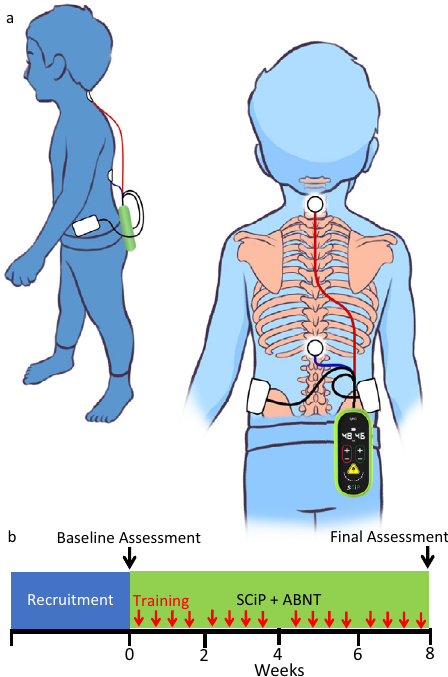
Fig. 1 | Overall Experimental Design. a Experimental setup demonstrating the placement of non-invasive electrodes over the cervical and thoracic regions of the spinalcordwhile the child is actively engaged inactivity based neurorehabilitation therapies, b Experimental design for each child including initial screening and recruitmentperiod,16trainingsessions(redarrows)overthe8weeksandbaseline and fi nal